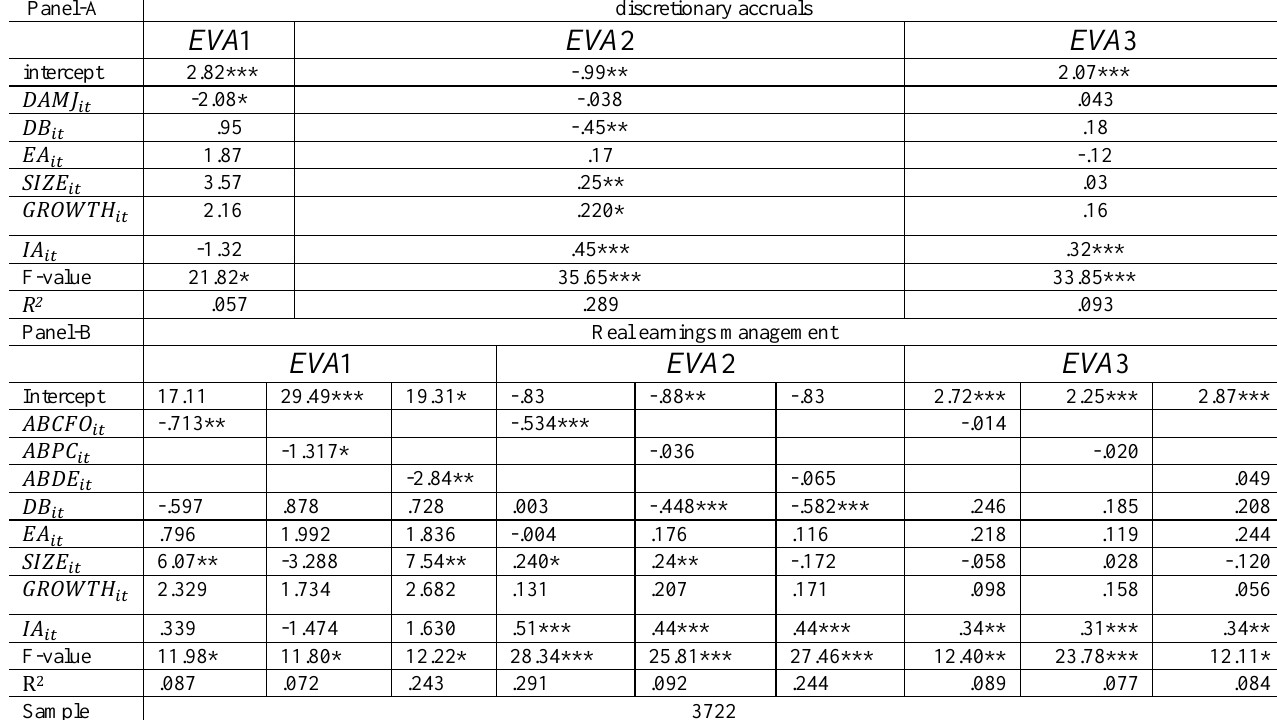
Table 2: Regressions of earnings management with economic value added (EVA) for North American Free Trade Agreement (NAFTA) nations Panel-A discretionary